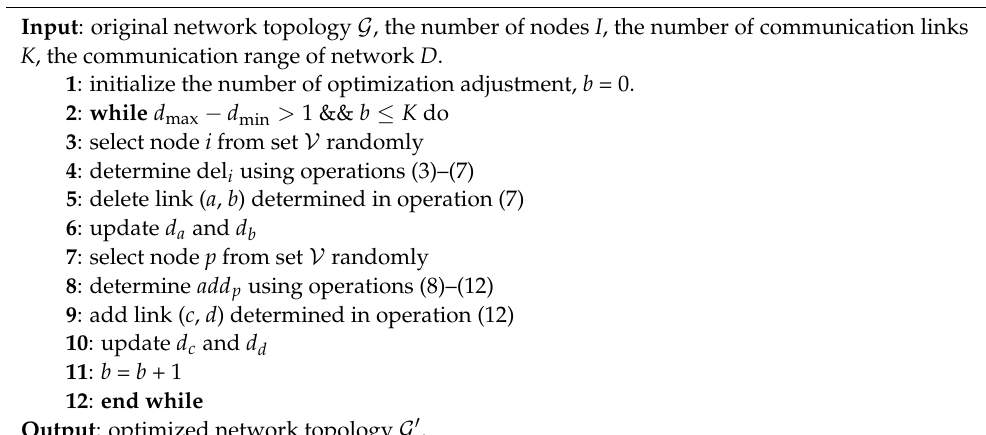
Algorithm 1 : A network topology optimization method according to local nodes’ topology parameter information.